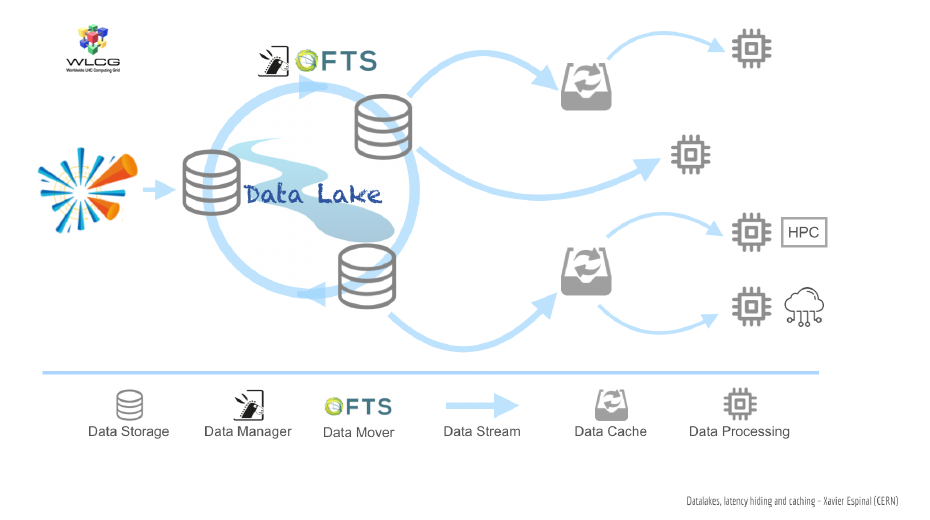
Figure 1. Conceptual sketch of the WLCG-Data